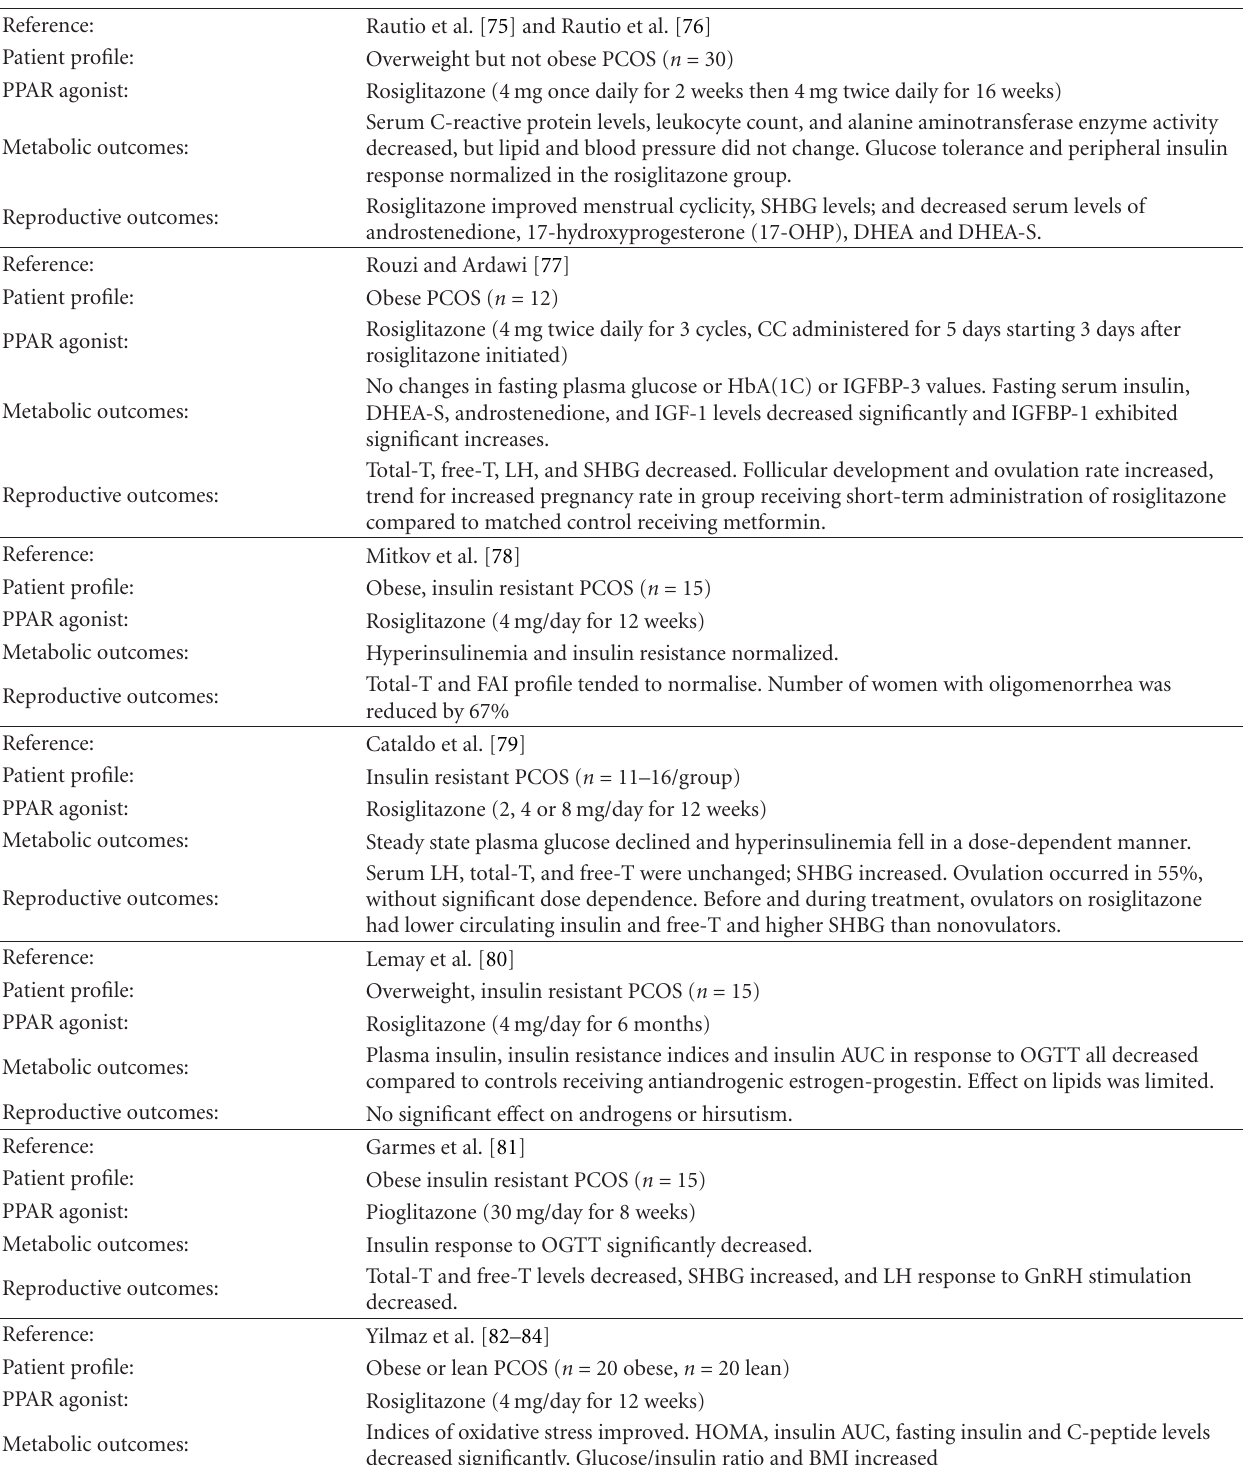
Table 2: Summary of reports published within the past 2 years on the use of PPARG activating agents for reproductive symptoms . Abbreviations used: AUC, area under the curve; BMI body mass index; CC clomiphene citrate; DHEA-S dehydroepiandrosterone sulfate; E2, estradiol; FAI, free androgen index; FSH, follicle-stimulating hormone; GnRH, gonadotropin releasing hormone; HbA(1C), haemoglobin A1C; HDL-C, high density lipoprotein-cholesterol; HOMA, homeostasis model of assessment for insulin sensitivity; IGF1 insulin-like growth factor 1; IGFBP-1/3, insulin-like growth factor binding protein 1 or 3; LDL-C, low density lipoprotein-cholesterol; LH, luteinizing hormone; OGTT, oral glucose tolerance test; PCOS, polycystic ovary syndrome; QUICKI, quantitative insulin-sensitivity check index; SHBG, sex hormone binding globulin; T, testosterone; WHR, waist to hip